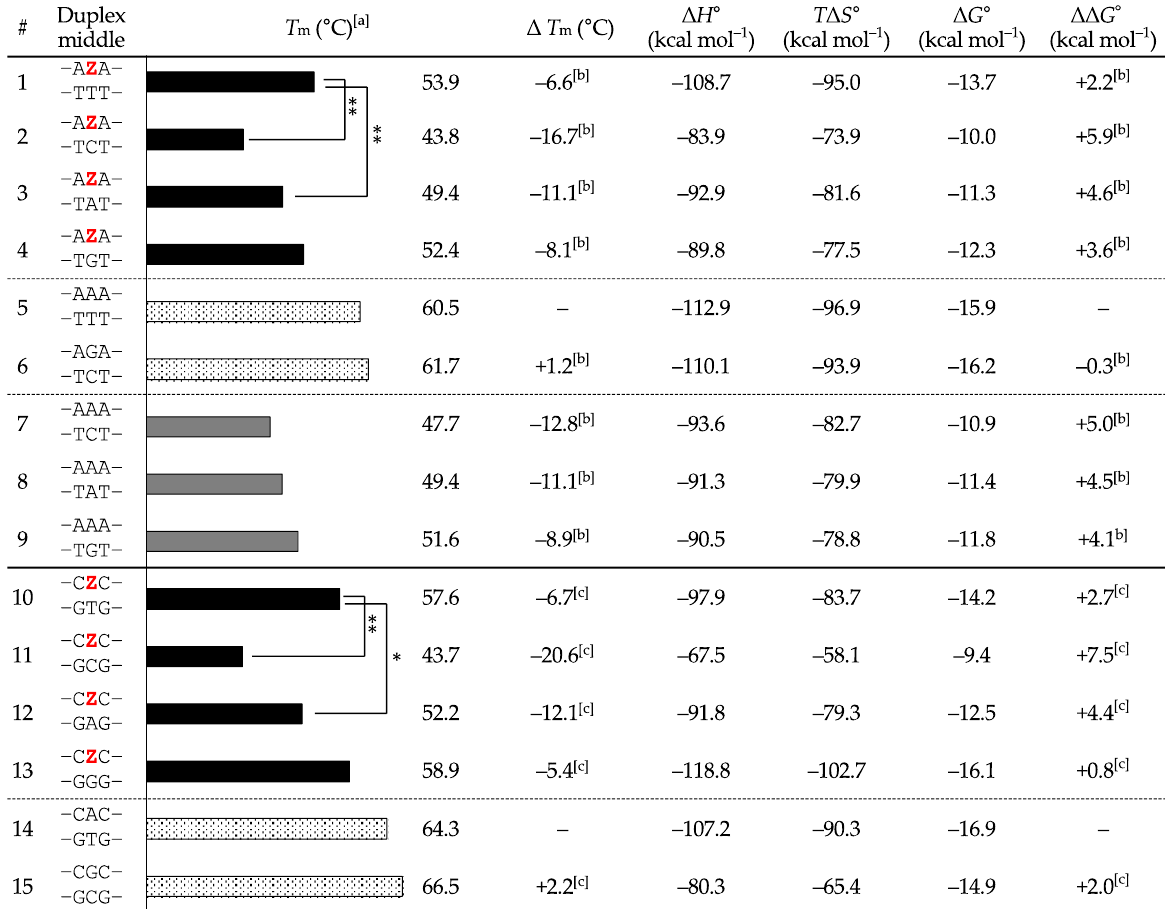
Figure 3. Thermal and thermodynamic parameters of DNA duplexes containing Z-base [a] . [a] All experiments were carried out in a buffer containing 100 mM NaCl, 10 mM Na2HPO4, and 1 mM Na2EDTA (pH 7.0). Thermodynamic parameters were derived from the average values obtained from curve fitting and Tm–1 versus ln(Ct/4) plots. Tm was calculated at a strand concentration of 10 μM. [b] ∆Tm and ∆∆G° values were calculated based on the values determined for a natural A:T pair (entry 5). [c] ∆Tm and ∆∆G° values were calculated based on the values determined for a natural A:T pair (entry 14). * p < 0.05 and ** p < 0.005 by Student’s t-test. Z-bases are highlighted in red.